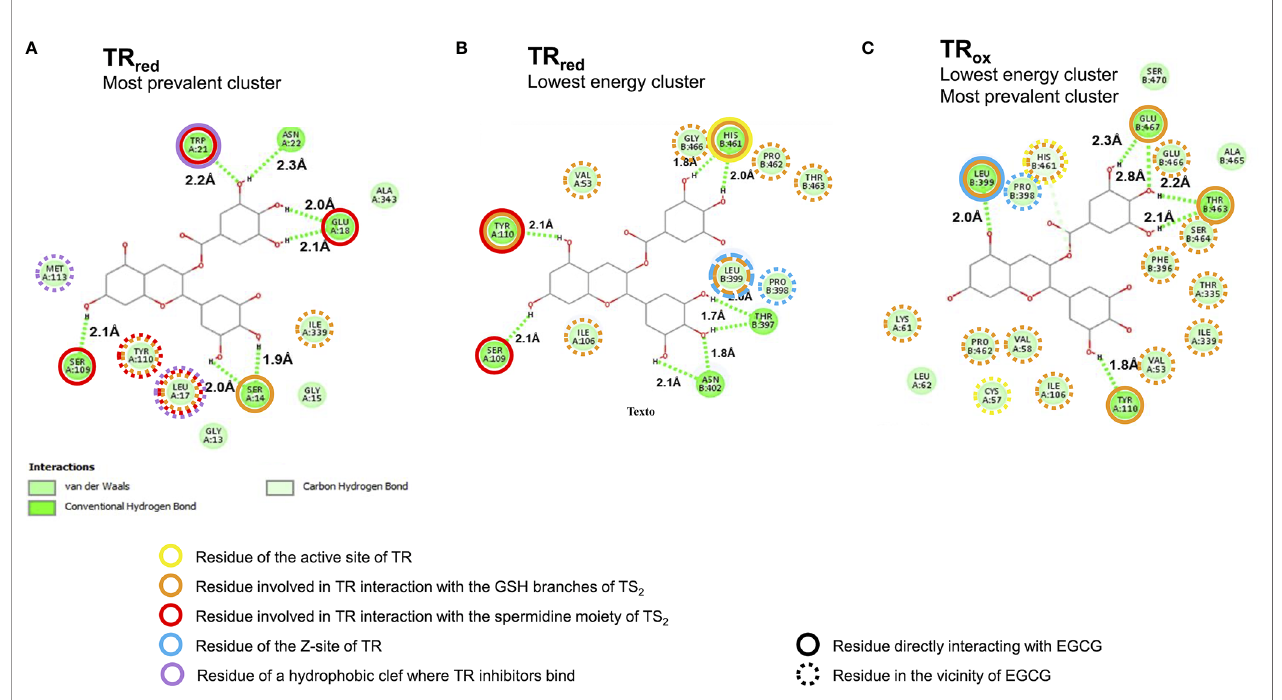
FIGURE 4 | High con fi dence in silico models predict EGCG binding to the trypanothione binding site of trypanothione reductase (TR). Two dimensional representation of the interaction between EGCG (central carbon structure) and TR residues (green circles with aminoacid numbering; the letters A and B refer to different monomers) in (A) the most prevalent and also lowest energy EGCG/TR ox cluster, (B) the lowest energy EGCG/TR red cluster, and (C) the most prevalent EGCG/TR red